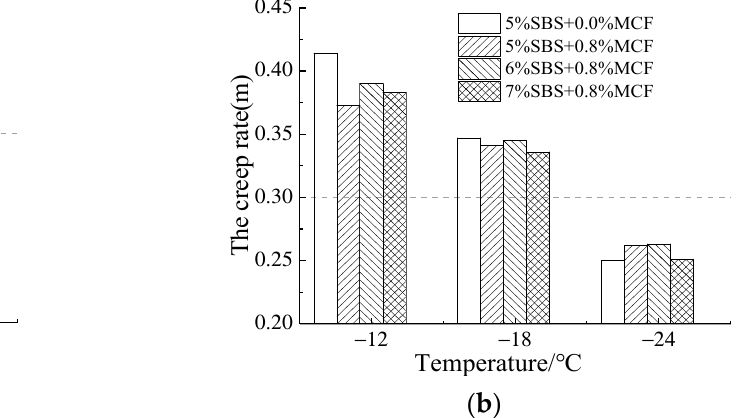
Figure 5. BBR results of modified asphalts at different temperatures. ( a ) Test results for S value; ( b ) Test results for m value.